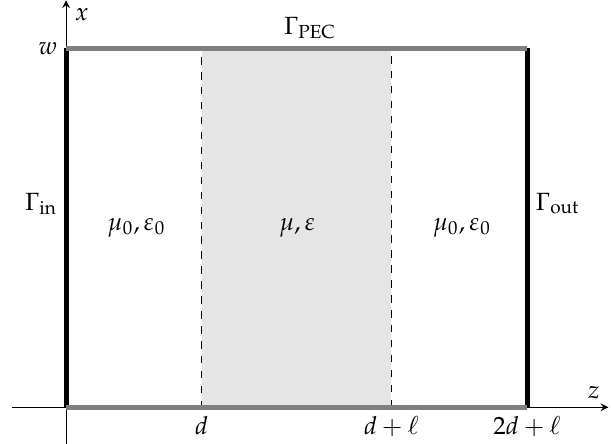
Figure 5. View of the waveguide in the xz plane. The input and output ports are shown in black, the PEC (perfect electric conductors) walls in dark gray, the vacuum-filled area in white, and the dielectric material in light